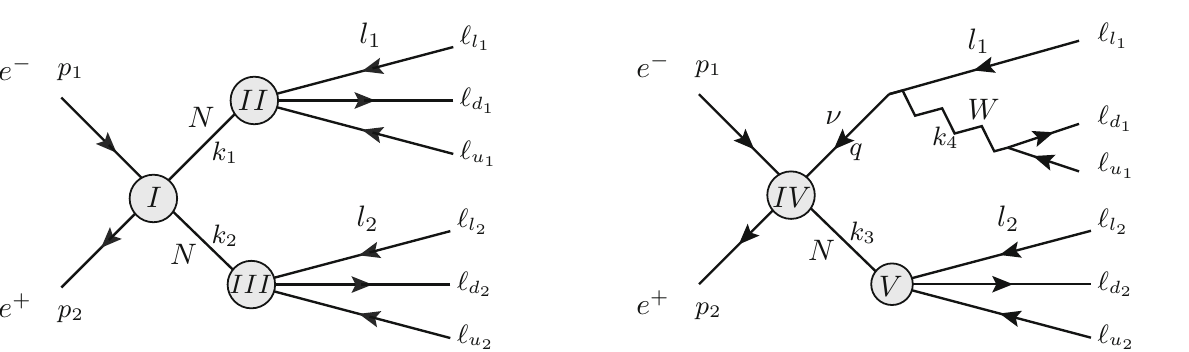
Fig. 1 Diagrams contributing to double N production Fig. 3 Diagrams contributing to single N production